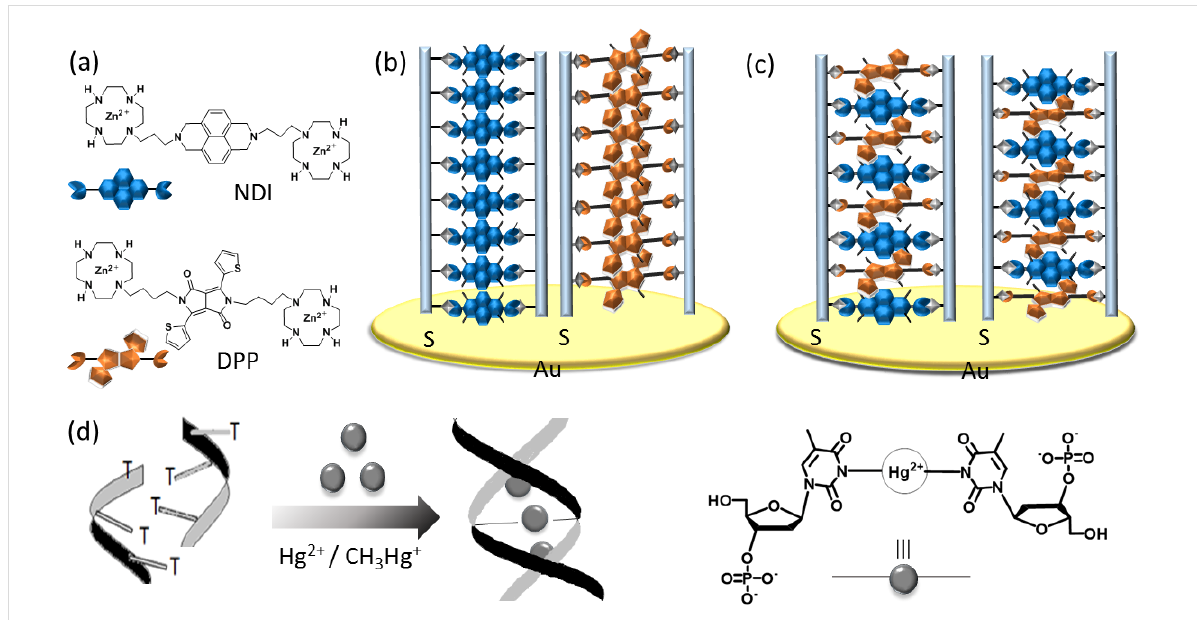
Figure 7: a) Zn(II)-cyclen-tethered NDI and DPP SFMs. b) DPP–dT 40 and NDI–dT 40 multichromophore arrays over a gold electrode via coimmobi- lizing donor–acceptor units. c) Random assembly of a DPP–NDI–dT 40 multichromophore array over a gold electrode. d) Formation of a metallo-DNA duplex through T–Hg(II)–T interactions, maintaining the 2:1 molar ratio of T and Hg(II). Figure 7a–c has been adapted with permission from [84], copy- right 2015 Wiley and Sons, and Figure 7d has been adapted from [86], copyright 2006 American Chemical